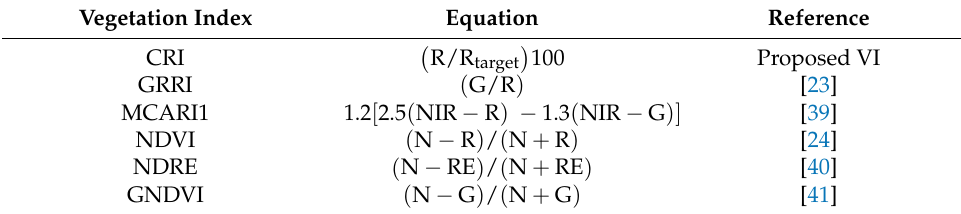
N, Near-infrared; R, Red; G, Green; RE, RedEdge; and R Target , Average reflectance value of the red target in